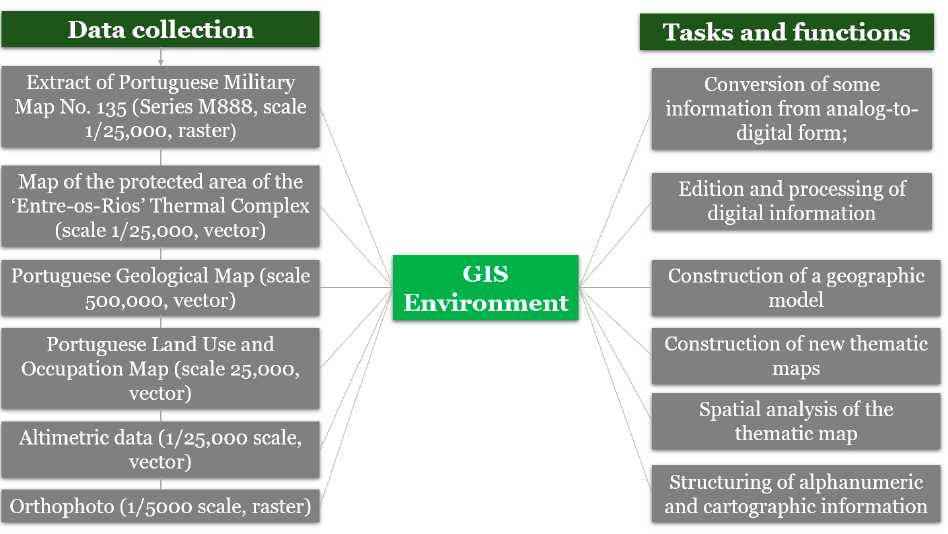
Figure 8. Flow chart of the variety of data that was collected and processed using ArcGIS tools and tasks and functions used.